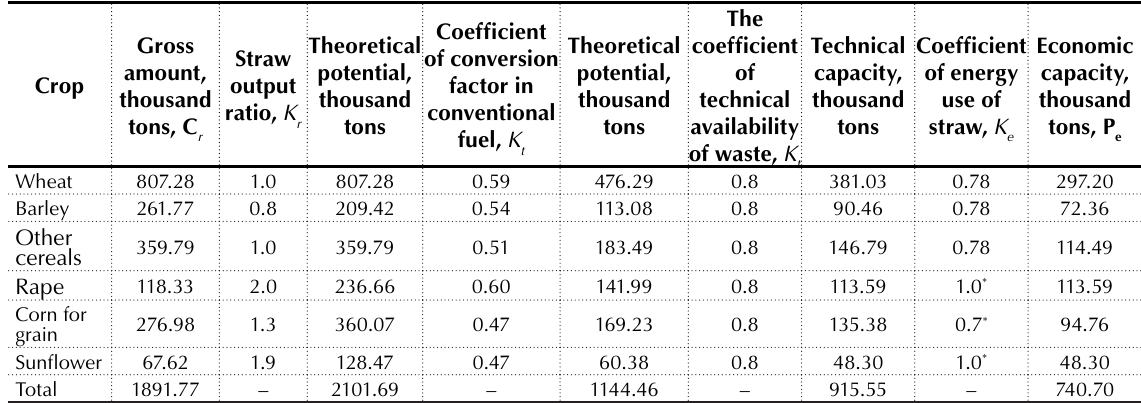
Table 4. Calculation of energy potential (Р